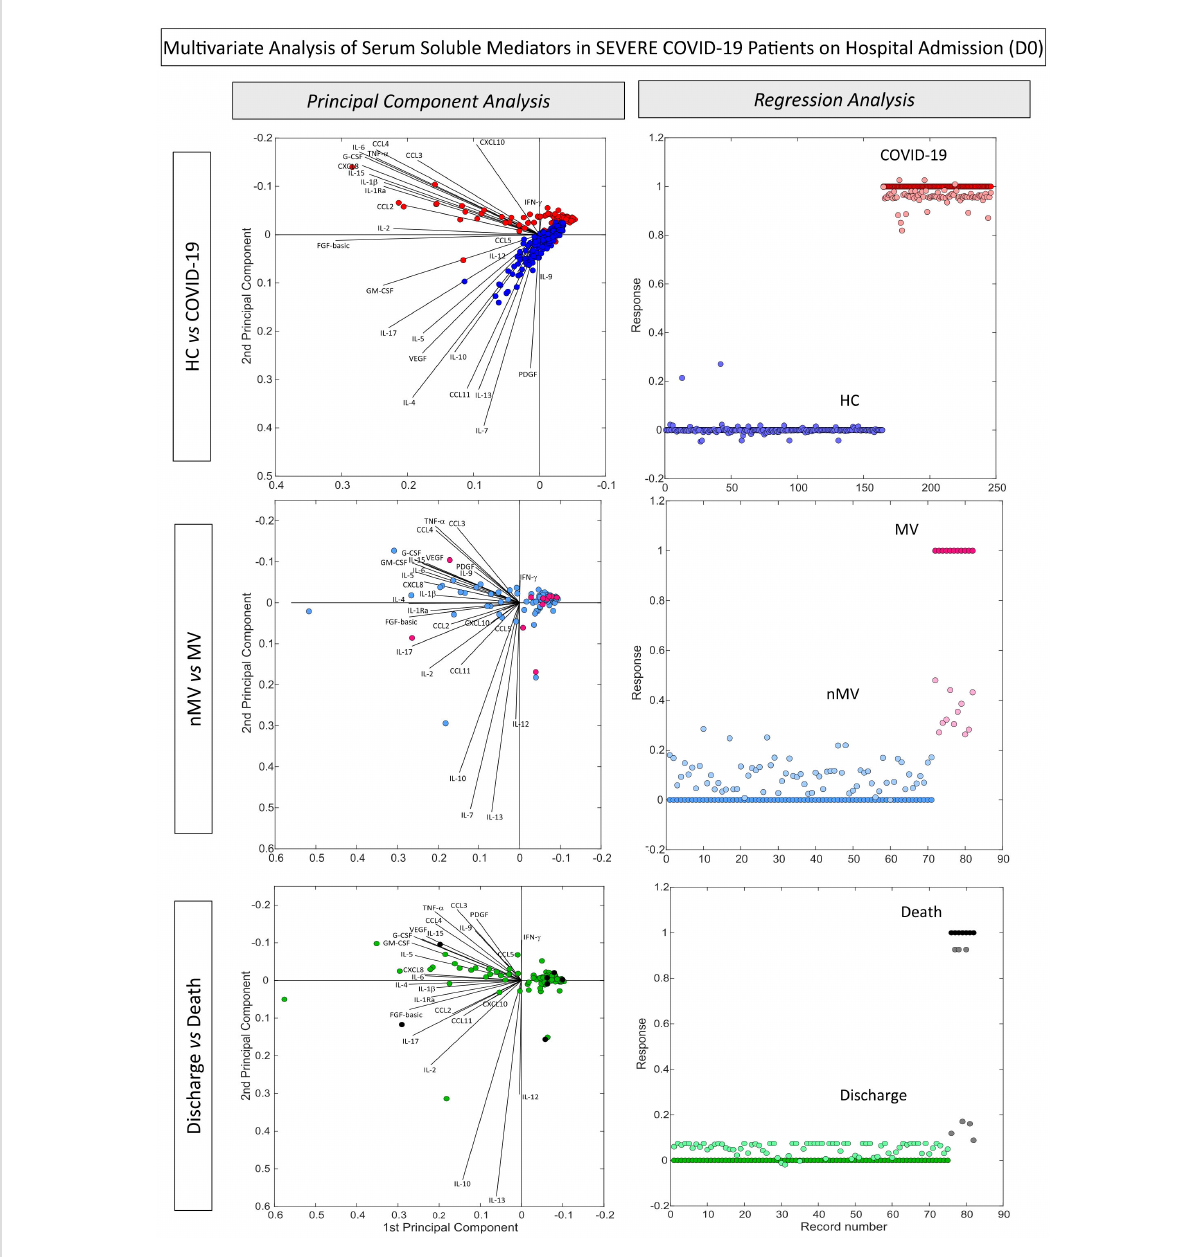
FIGURE 3 Multivariate analysis of serum soluble mediators in severe COVID-19 patients according to disease outcome. Multivariate analysis of serum chemokines, pro-in fl ammatory cytokines, regulatory cytokines and growth factors were performed to verify the ability of serum soluble mediators to cluster COVID-19 (n=82) apart from and non-infected pre-pandemic Healthy Controls (HC, n=164) as well as subgroups of COVID-19, according to disease outcome, referred to as: Non-Mechanical Ventilation (nMV, n=71) vs Mechanical Ventilation (MV, n=11) and Discharge (n=75) vs Death (n=7). The soluble mediators were measured by Luminex Bio-Plex platform as described in Material and Methods. Principal Component Analysis (PCA) and multivariate regression analysis were carried out by MATLAB software as described in Material and Methods. PCA coordinates (1 st and 2 nd principal components) were used to compare and visualize the grouping of COVID-19 vs HC, nMV vs MV and Discharge vs Death. The multivariate regression model was trained using regression learner, assigning values of 0 to COVID-19, nMV and Discharge classes and values of 1 to HC, MV and Death classes. The selected model for analysis was obtained after 10 times training based on the highest